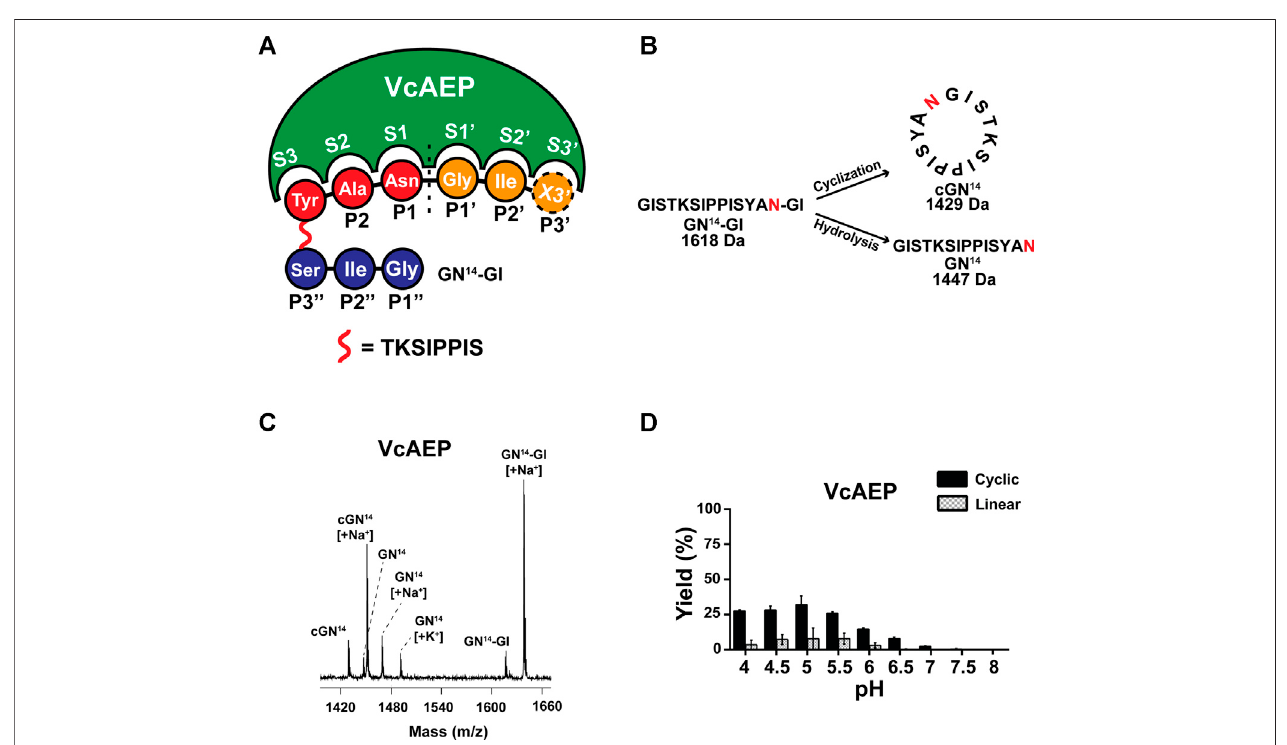
FIGURE2| AnalysisofVcAEP AEP activity. (A) NomenclatureofAEP/PAL and substrate, using thepeptidesubstrate GN 14 -GI (GISTKSIPPISYAN-GI) asamodel. Based on the nomenclature of substrate binding of protease proposed by Schechter and Berger, the cleavage site of the substrate is named P1 (red), and the corresponding binding pocket of the enzyme is S1. After cleavage, the amino acid residues of leaving group are P1 ′ , P2 ′ , P3 ′ Etc (orange). For PALs to cyclize or ligate substrate, the amino acid residues of the incoming group are P1 ″ , P2 ″ , P3 ″ etc., (blue). X stands for the 20 amino acids. (B) Schematic representations of AEP- mediatedcyclizationand hydrolysis ofthe16-residue peptide substrate GN 14 N-GI(MW 1618 Da).TheP1-Asnposition iscolored red.Theenzymatic reaction ofVcAEP yields two products: the 14-residue cyclic product cGN 14 (1429 Da) and 14-residue linear product GN 14 (1447 Da) with release of a GI dipeptide. (C) Representative MALDI-TOF mass spectrometry of the cyclic product cGN 14 and the linear product GN 14 generated by VcAEP together with GN 14 N-GI as the starting material. The reactionwasconducted atpH6,at37 ° Cfor15 minwitha1:20molarratioofenzyme:substrate. (D) ProductyieldsofVcAEPwildtypewerequanti fi edbycalculatingthe peak areas of MALDI-TOF mass spectrometry. Gray and black bars indicate the percentage yield of linear product and cyclic product, respectively. The reactions were conducted at 37 ° C for 15 min with a molar enzyme:substrate ratio of 1:20 (VcAEP). Average yield and SDs were calculated from experiments performed in triplicate.